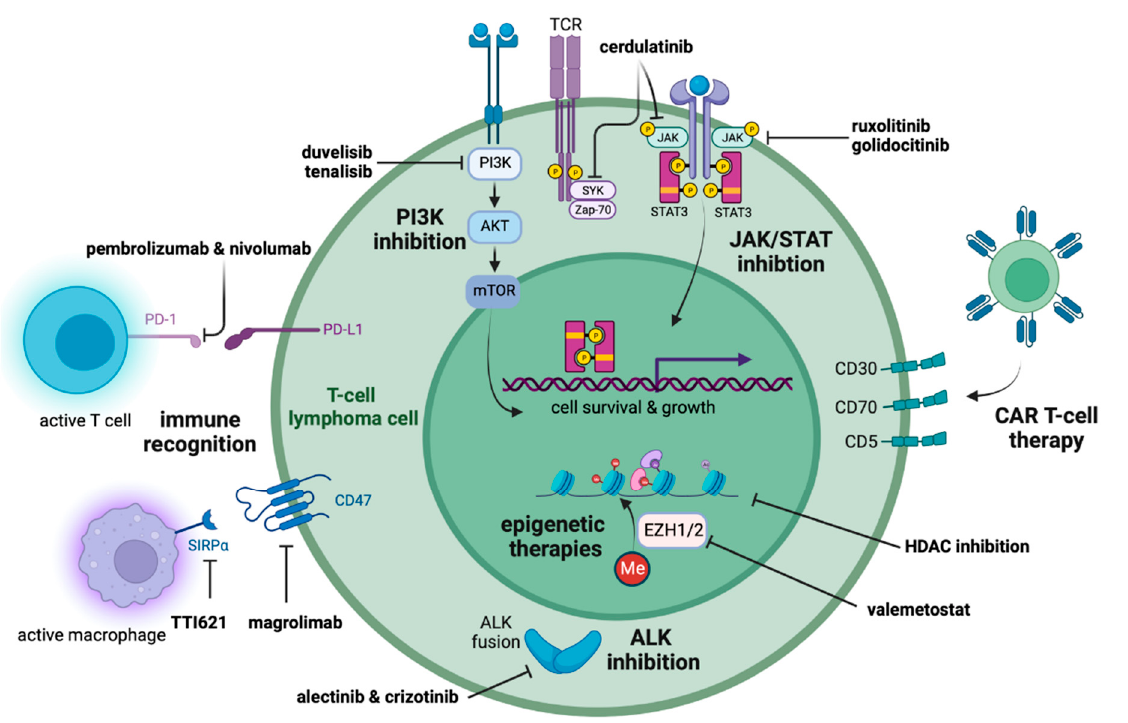
Figure 1. Selected therapeutic advances in peripheral T-cell lymphomas. From top left, clockwise: PI3K inhibition: Duvelisib and tenalisib are dual inhibitors of the PI3K/AKT/mTOR pathway through PI3K γδ inhibition. JAK/STAT inhibition: Cerdulatinib is a dual inhibitor of JAK/SYK. Ruxolitinib and golidocitinib are JAK1/2 and JAK1 inhibitors of the JAK/STAT pathway, respectively. CAR T-cell therapy: CAR T-cell therapy remains in early study in T-cell lymphoma, with targets including CD30, CD70, CD5, and others. Epigenetic therapies: Epigenetic therapies include continued use of HDAC inhibition, as well as exploration of combination therapies using HDAC inhibitors plus other molecules. Valemetostat is an EZH1/2 inhibitor. ALK inhibition: Alectinib and crizotinib inhibit ALK fusion proteins in ALK + ALCL. Immune recognition: Immune recognition strategies include interruption of the CD47-SIRP α axis and checkpoint blockade in particular histologies (EBV+ T-cell lymphoma, NK/T-cell lymphoma, cutaneous T-cell lymphoma). Abbreviations: ALK, anaplastic lymphoma kinase; CAR, chimeric antigen rector; EZH, enhancer of zeste homolog; HDAC, histone deacetylase inhibitor; JAK, Janus kinase; Me, methyl; mTOR, mammalian target of rapamycin; PD-1, programmed cell death protein 1; PD-L1, programmed death-ligand 1; SIRPa, signal regulatory protein α ; STAT, signal transducer and activator of transcription; SYK, spleen tyrosine kinase; TCR, T-cell receptor; Zap-70, Zeta-chain-associated protein kinase-70. Created in BioRender.com. The Janus kinase (JAK)/signal transducers and activators of transcription (STAT) pathway is a second integral pathway influencing T-cell differentiation and function.